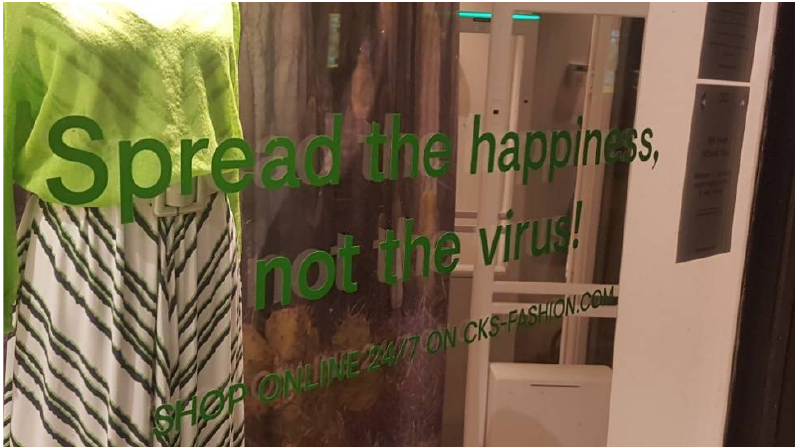
Figure 8. Spread the happiness, not the virus!